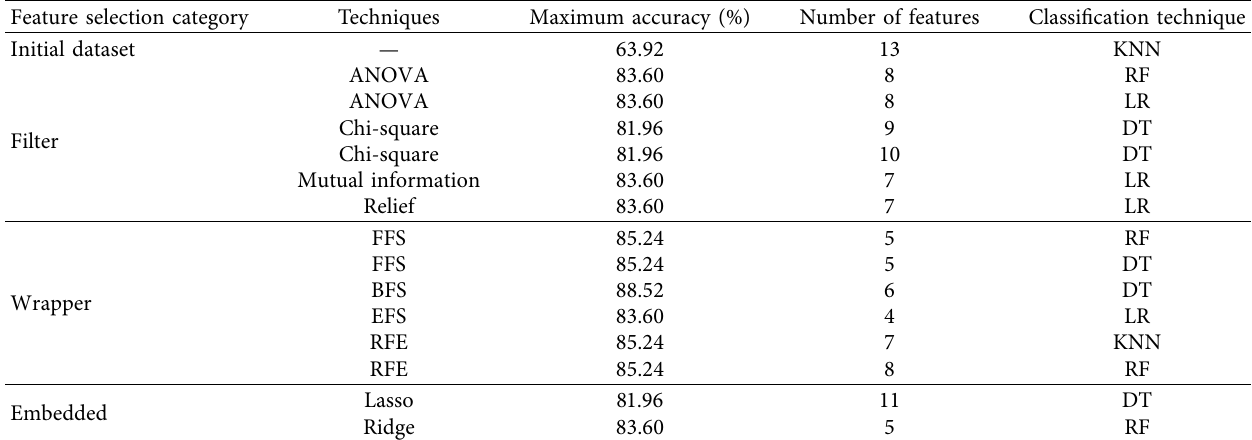
Table 7: Summary of